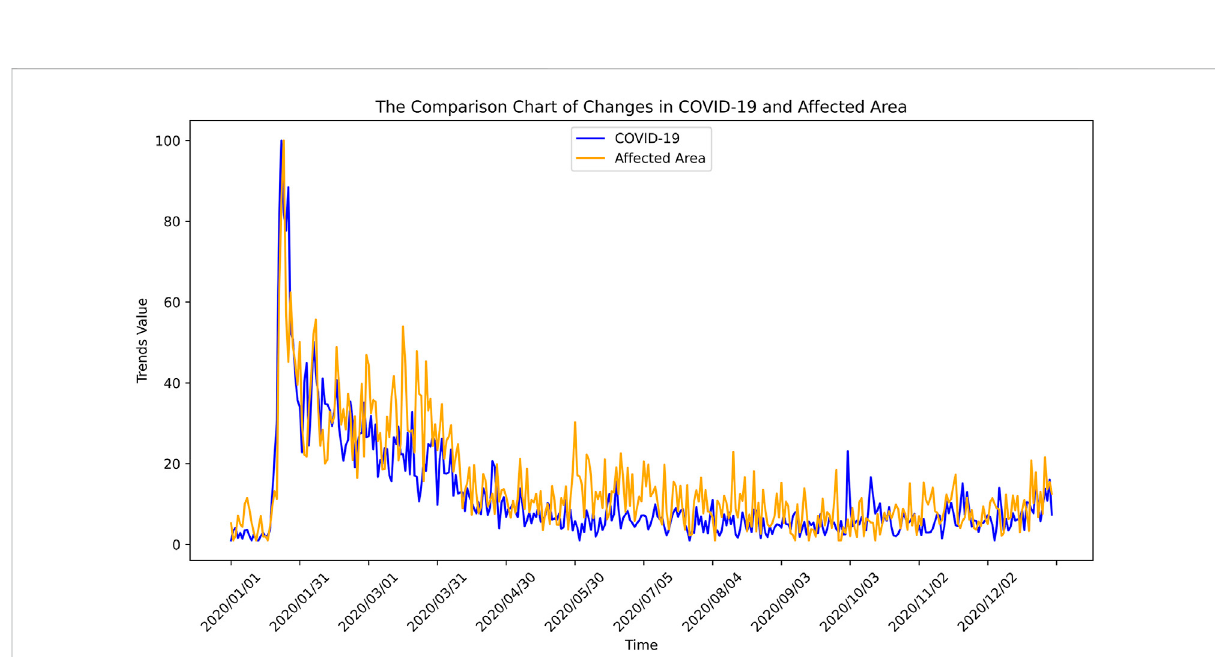
FIGURE 3 The comparison chart of changes in the attention of COVID-19 and affected